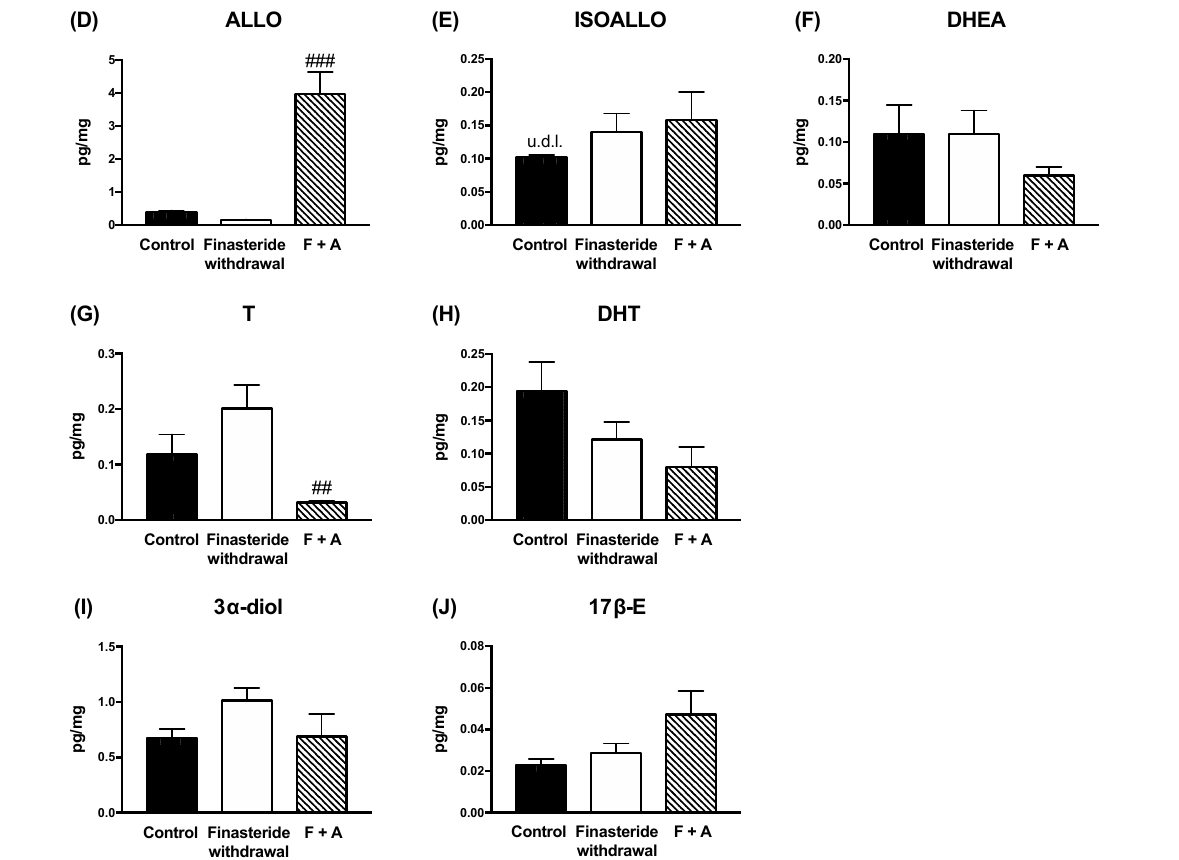
Figure 6. Levels of gut steroids in the colon of control, finasteride-treated rats and ALLO-treated rats: effect at withdrawal (F + A). Pregnenolone (PREG, ( A )), progesterone (PROG, ( B )), dihydroprogesterone (DHP, ( C )), allopregnanolone (ALLO, ( D )), isoallopregnanolone (ISOALLO, ( E )), dehydroepiandrosterone (DHEA, ( F )), testosterone (T, ( G )), dihydrotestosterone (DHT, ( H )), 5 α -androstane-3 α , 17 β -diol (3 α -diol, ( I )) and 17beta-estradiol (17 β -E, ( J )). Data are expressed as pg/mg ± SEM, n = 7 for each group. The effect of treatment with ALLO was analyzed using one-way ANOVA followed by Uncorrected Fisher’s LSD post hoc test (significance: ** p < 0.01 vs. control group; ## p < 0.01; ### p < 0.001 vs. finasteride-treated rats). u.d.l. = under the detection limit. The detection limit was 0.1 pg/mg for isoallopregnanolone.